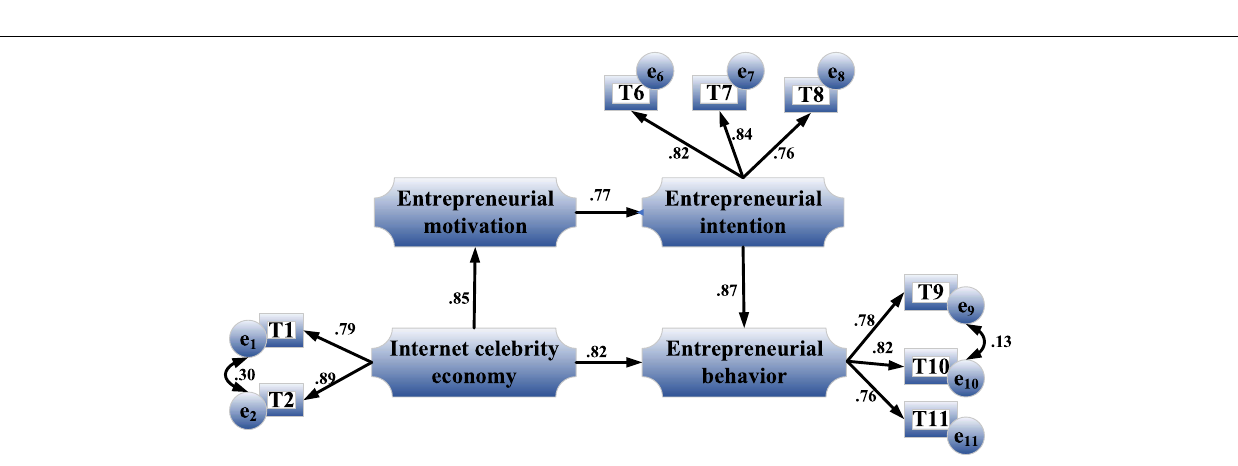
Frontiers in Psychology |